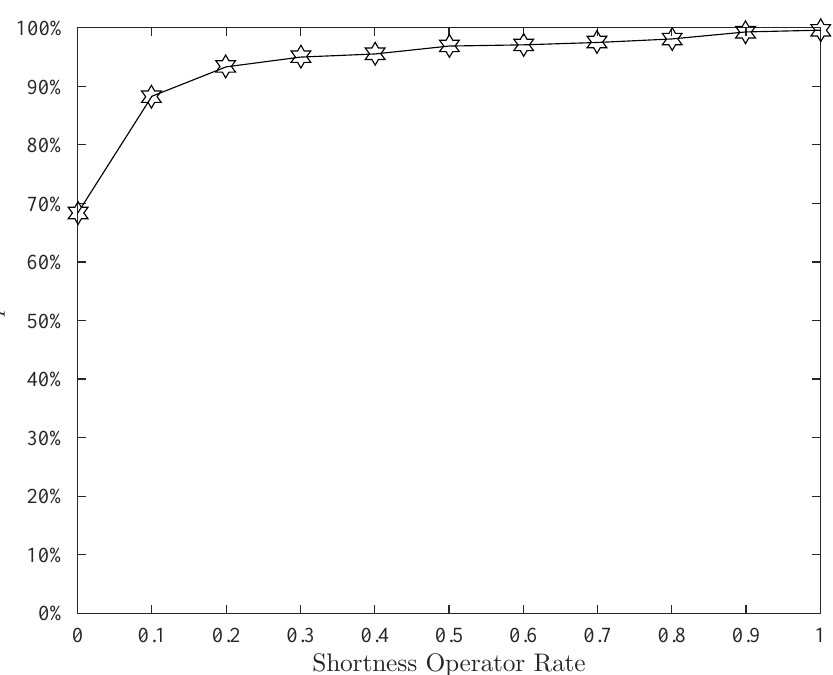
Figure 16. Effect of the crossover rate.